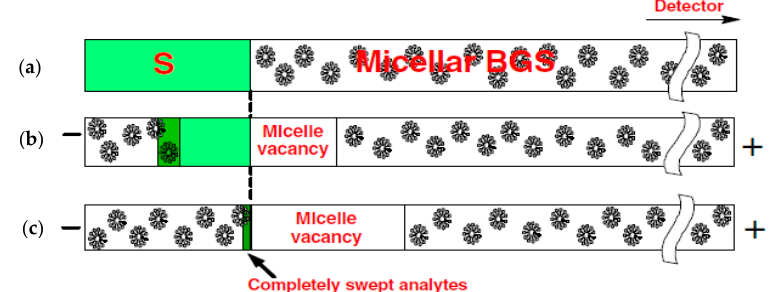
Figure 2. Principle of the sweeping in a homogenous electric field. ( a ) At beginning, the capillary is filled with analyte solution (S) and micellar background solution (BGS), and the two portions have a similar conductivity. ( b ) Application of a voltage electrophoretically drives the pseudo-stationary phase (PSP) into the S zone, and at the same time the moving PSP sweeps analyte molecules to compress the S zone. ( c ) As PSP completely fills the S zone, the analytes are completed swept to form a concentrated band. Reprint from Ref. [17].